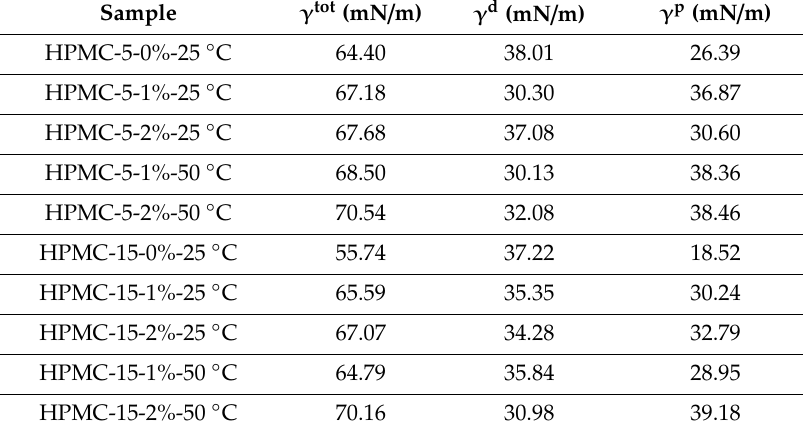
Table 1. The results of surface free energy ( γ tot ) and polar ( γ p ) and disperse ( γ d ) components.